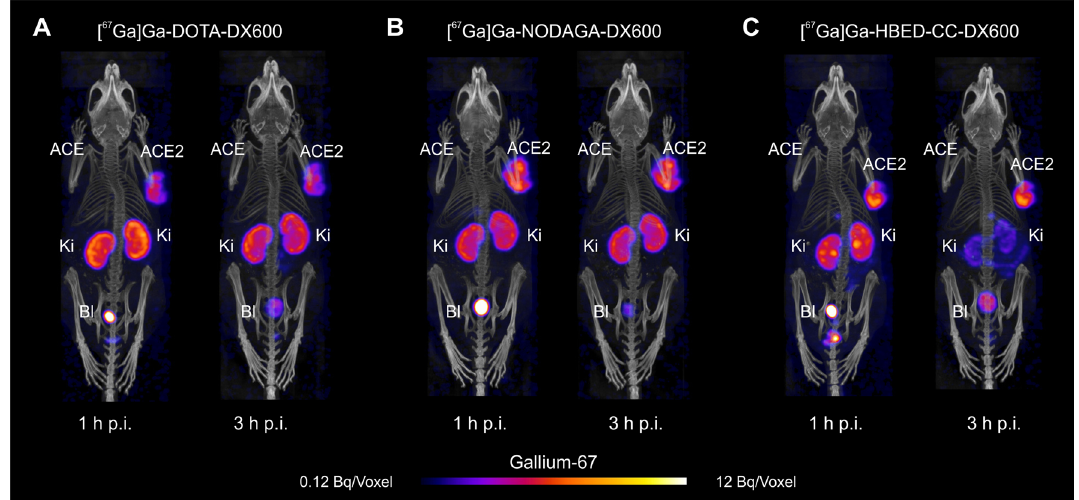
Fig. 7 Representative SPECT/CT images of HEK‑ACE2/ACE xenograft‑bearing mice obtained 1 h and 3 h after injection of the radiopeptides. A [ 67 Ga]Ga‑DOTA‑DX600; B [ 67 Ga]Ga‑NODAGA‑DX600 and C [ 67